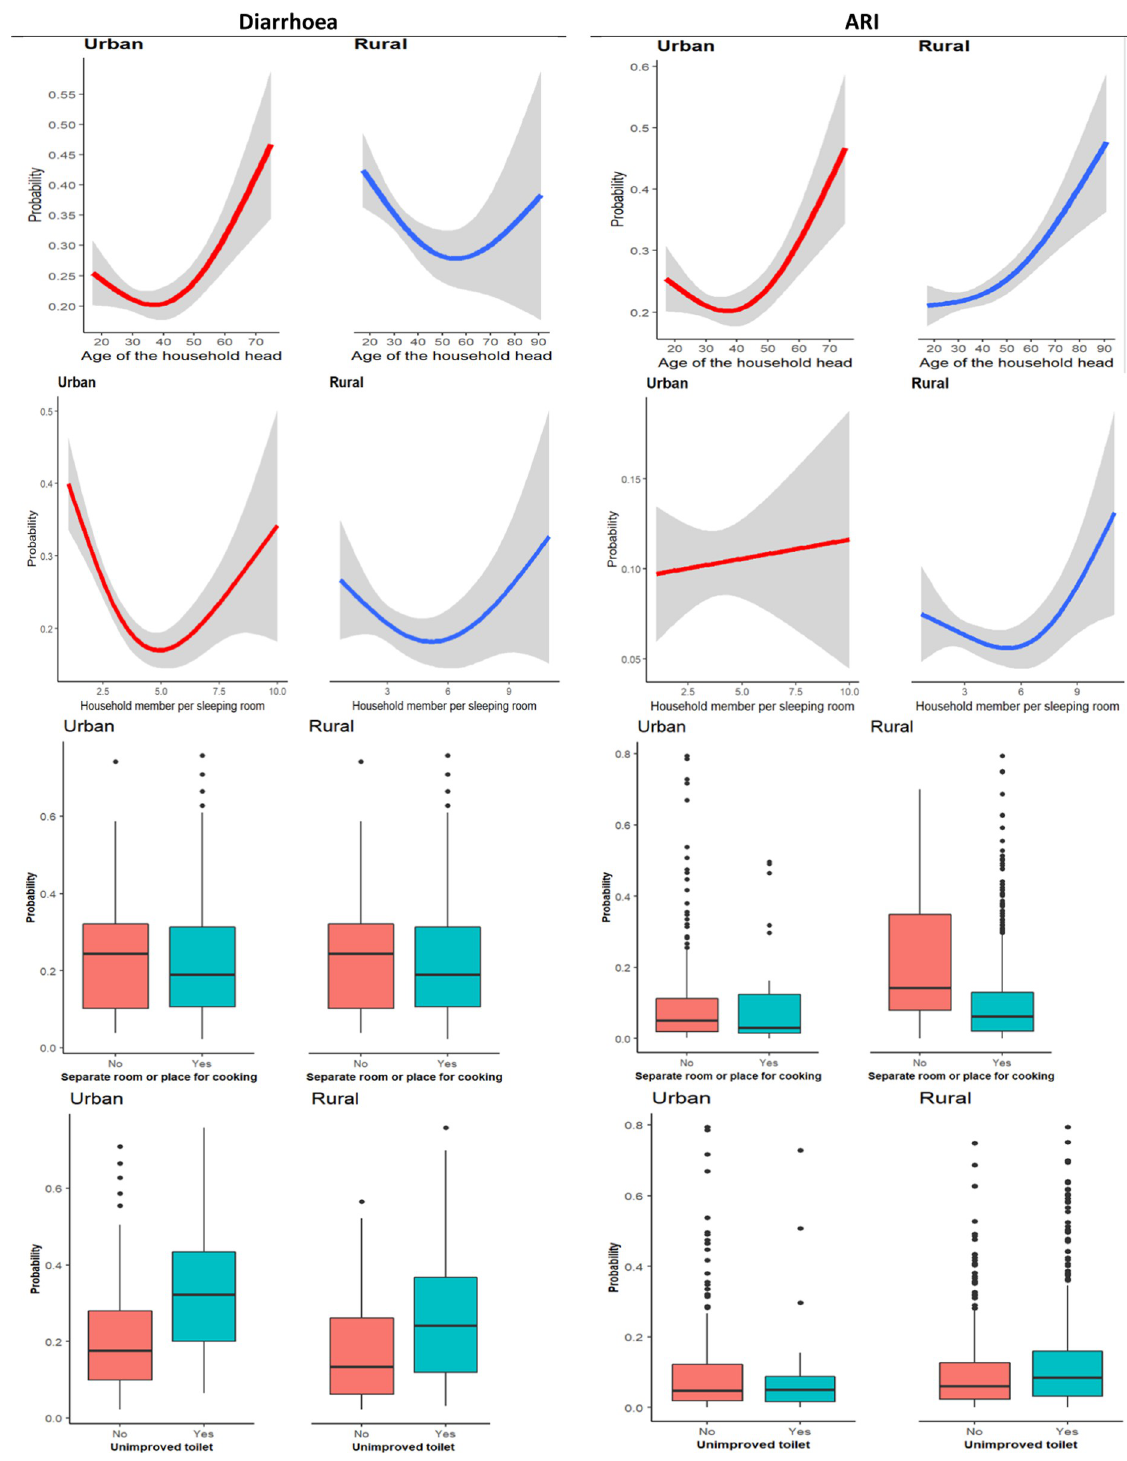
Fig 6. Association of household characteristics with child morbidities.